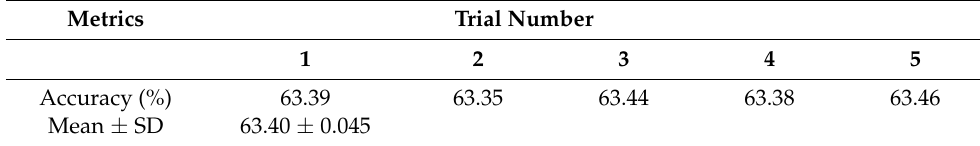
Table 5. Performance variance through repeated runs on the Blogs50